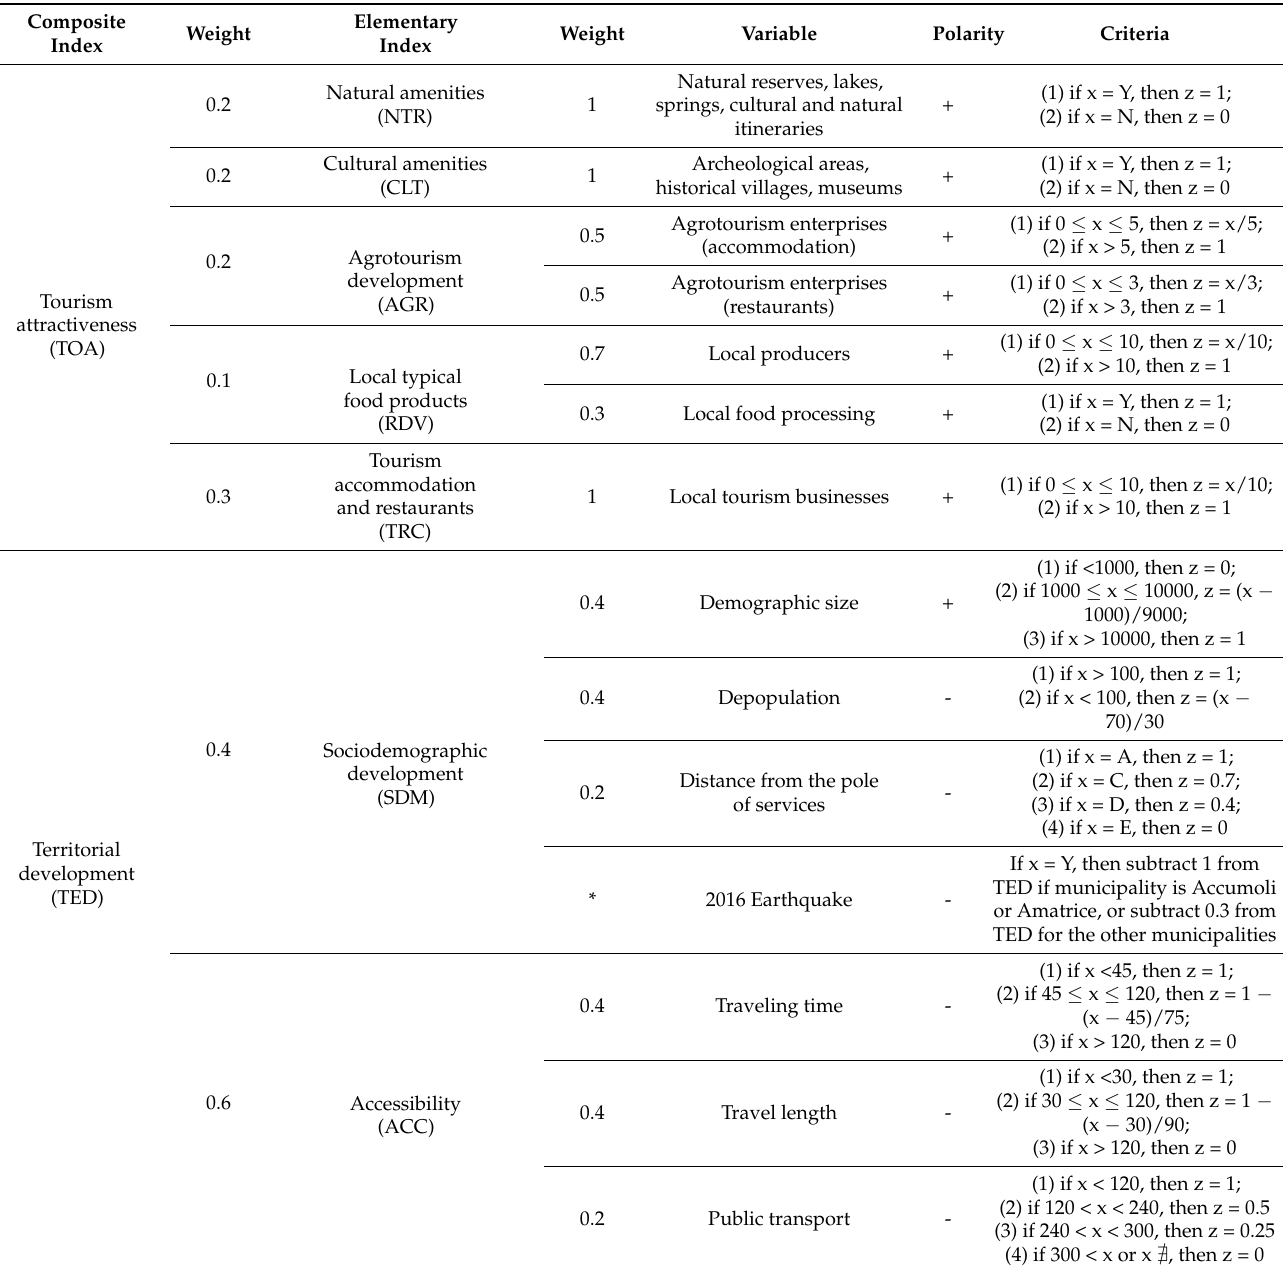
Table 3. An overview of the two composite indicators used in the multidimensional analysis. Au- thor’s own